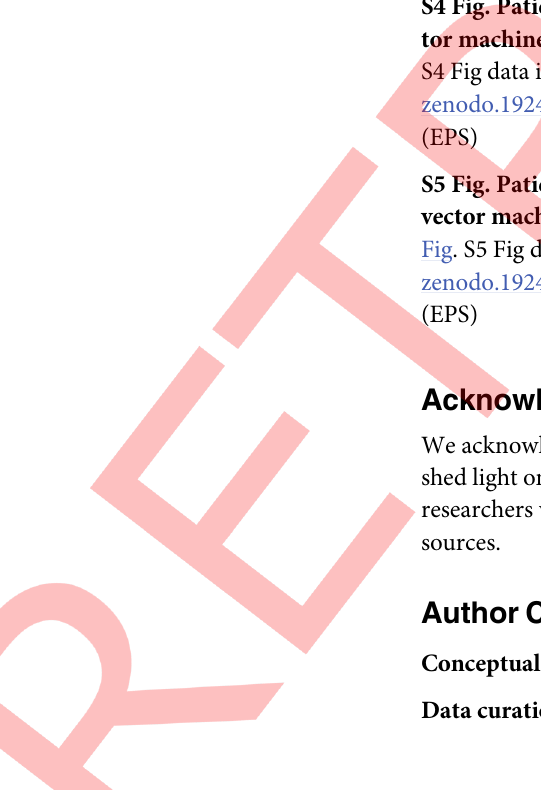
S4 Fig. Patient B. Receiver operating characteristic (ROC) curve of the binary support vec- tor machine (SVM) classifier. The description of this figure is the same as described in S2 Fig. S4 Fig data is located at, https://doi.org/10.5281/zenodo.192406; https://doi.org/10.5281/